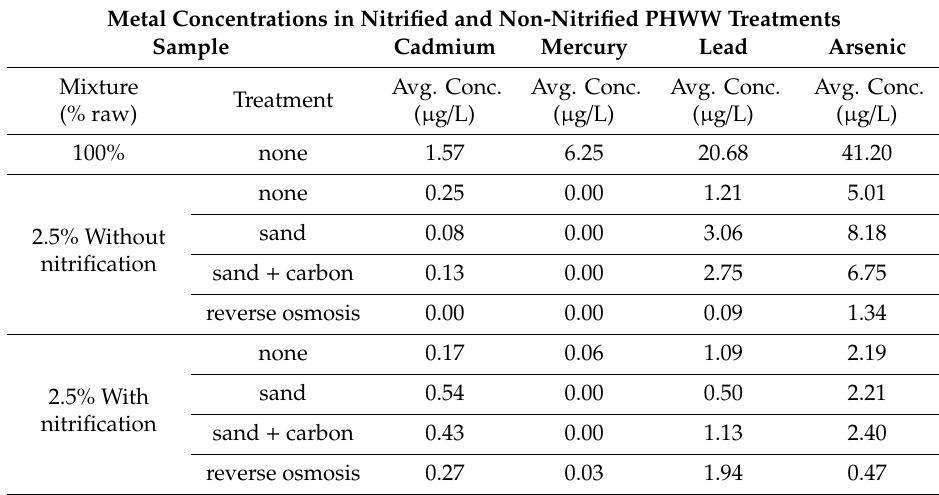
Table 4. Metal concentrations in the raw PHWW and treated PHWW with and without nitrification. Concentrations are shown in µ g /